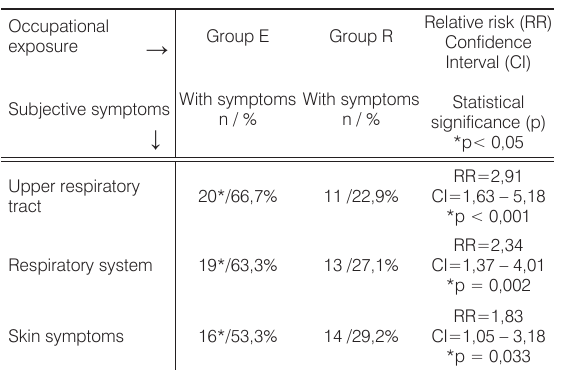
Table 2. Distribution of subjective symptoms manifestation among the group of occupationally exposed to formaldehyde and the referents (*p <0,05).